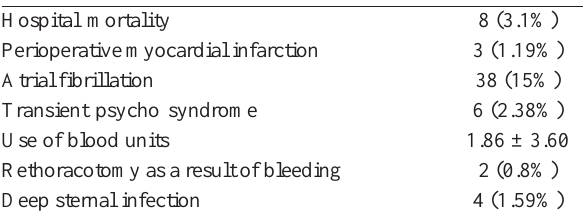
Table 3. Postoperative